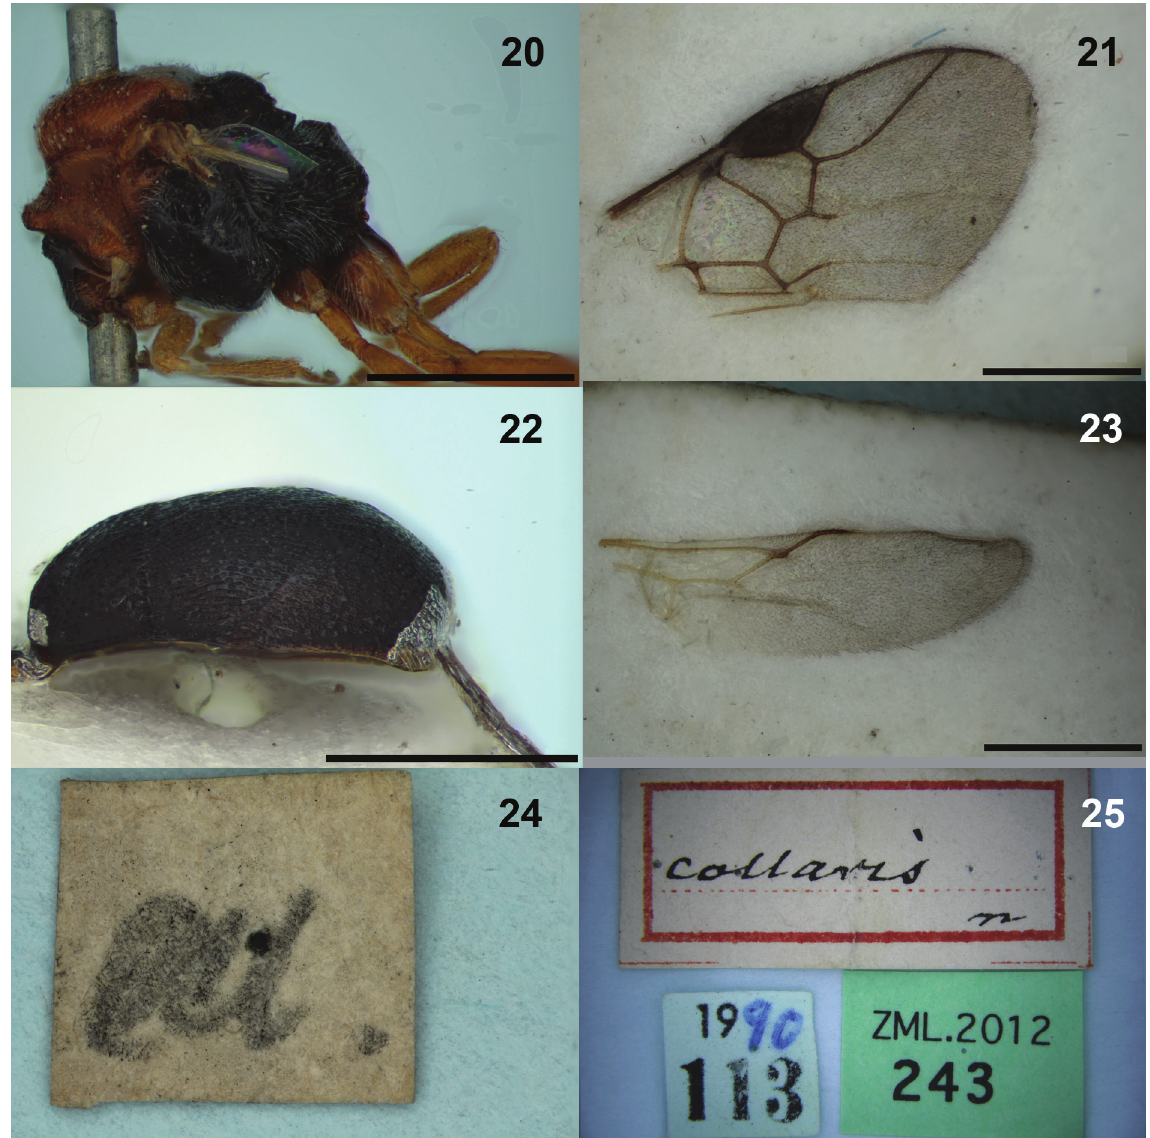
Figs 20–25. Schizoprymnus collaris (Thomson, 1874), ♀, lectotype. 20 . Lateral mesosoma. 21 . Fore wing. 22 . Lateral metasoma. 23 . hind wing. 24 . thomson’s locality label. 25 . other labels. Scale bars all 1 mm. © Natural history Museum,